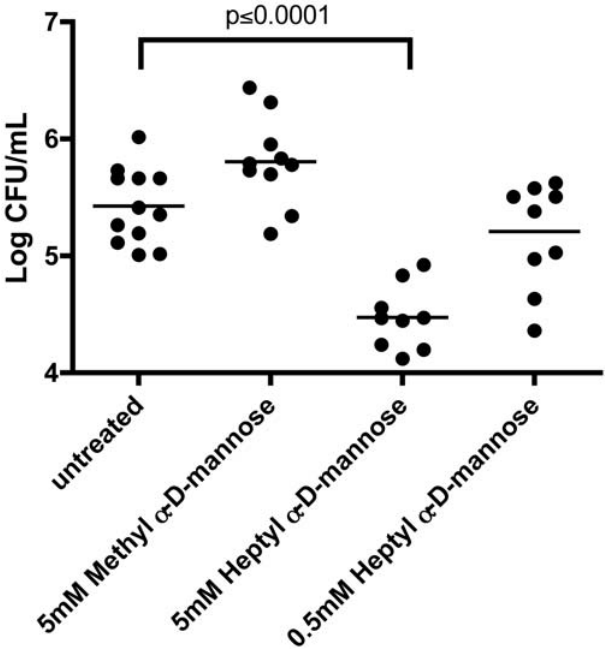
Figure 7. Bacterial load in the mouse bladder 6 hours post- infection. Mice were inoculated with UTI89, either untreated or treated with MM or HM. At 6 hours post-infection there was a significant decrease in the amount of bacteria treated with 5 mM HM in the bladder (p # 0.0001 by Mann Whitney test). This same decrease was not observed with bacteria treated with 5 mM MM. Bacteria treated with 0.5 mM HM were not significantly reduced relative to the untreated